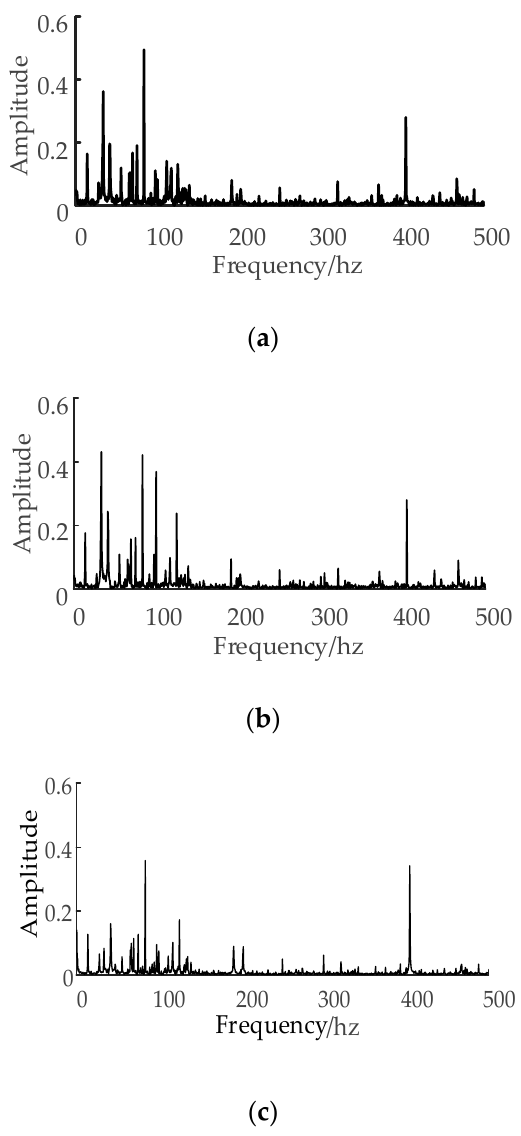
Figure 4. ( a ) Amplitude-frequency chart of the current signal at the initial tool wear stage, ( b ) the normal tool wear stage, and ( c ) the sharp tool wear stage.